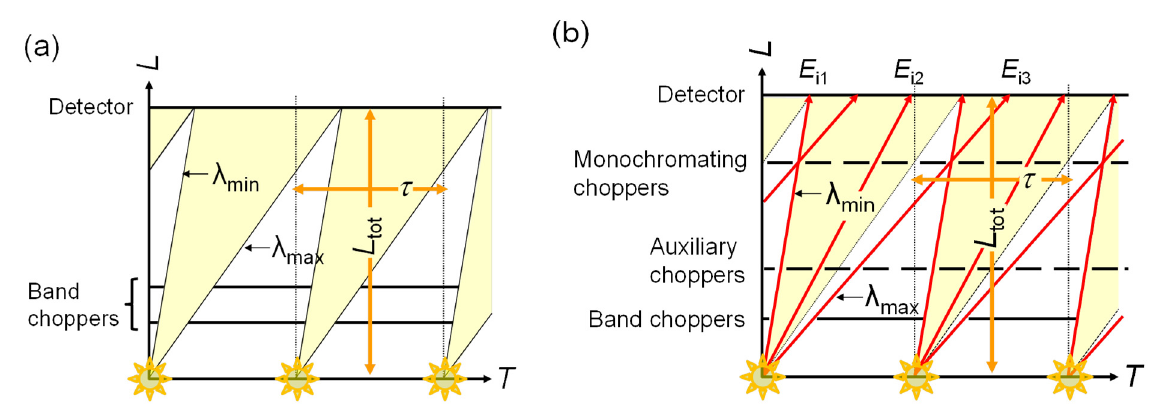
Fig. 1. A TOF diagram explaining the possible band width at a pulsed source. (a) In the conventional case. Available maximum time window at the detector position is t , the interval time of the source pulses. The possible wave length band, Δλ = λ max − λ min is determined by t and the total flight distance, L tot . (b) The interveined trajectory case. Three E i s are selected in the figure, namely E i1 , E i2 , and E i3 . Here, trajectories of E i1 and E i3 are crossing at the same monochromating chopper opening, i.e., the interveined trajectory. The effective wave length band, Δλ = λ max − λ min is wider than it is in the conventional case. The auxiliary chopper in the figure is optional. In the figures, L and T stand for the flight path length and the time-of-flight, respectively.